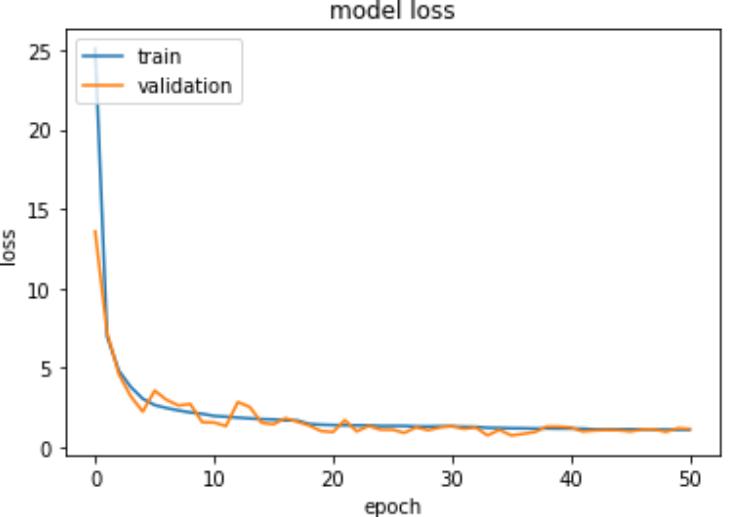
Figure 6. Training loss and validation loss curves of InceptionResnetV2 in transfer learning mode.